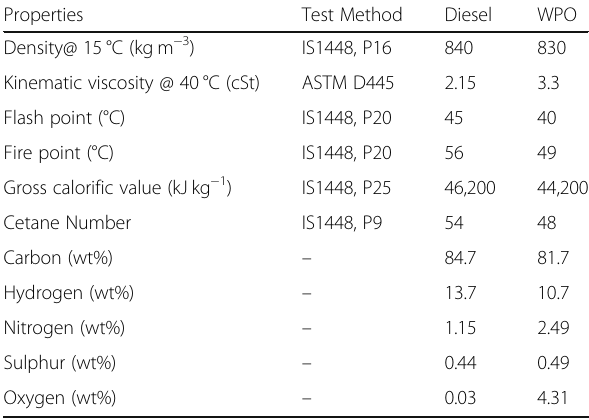
Table 2 Properties of diesel and waste plastic